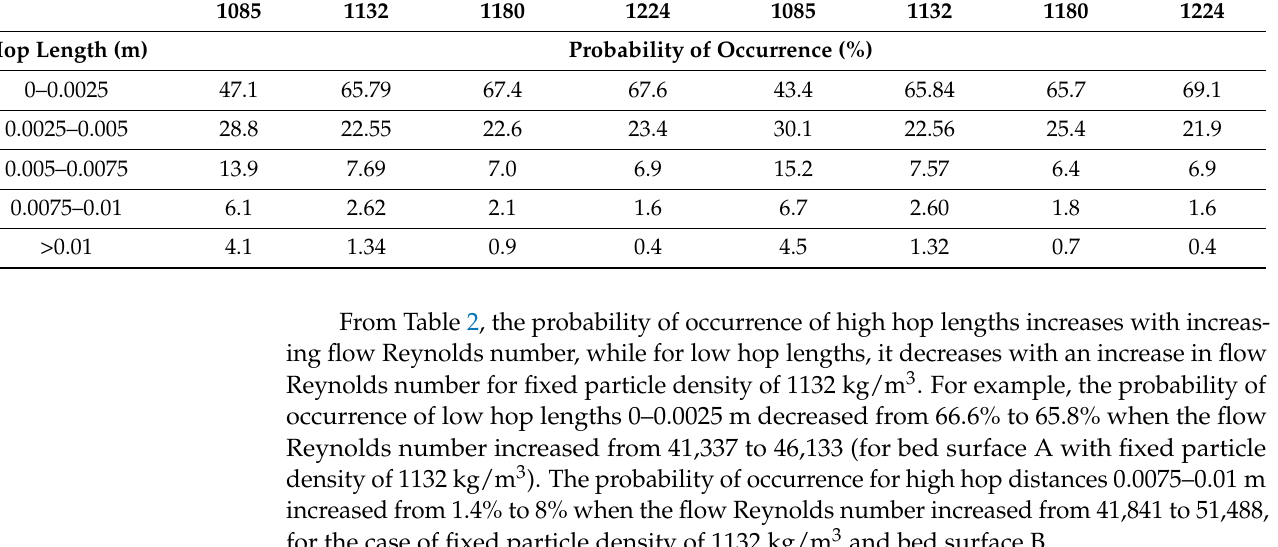
Table A2. The effect of different flow Reynolds numbers on the hop distance Gamma distribution model parameters, for bed surfaces A and B, for fixed particle density of 1132 kg/m 3 . These tabulated data correspond to the results plotted in Figure 11a,c.